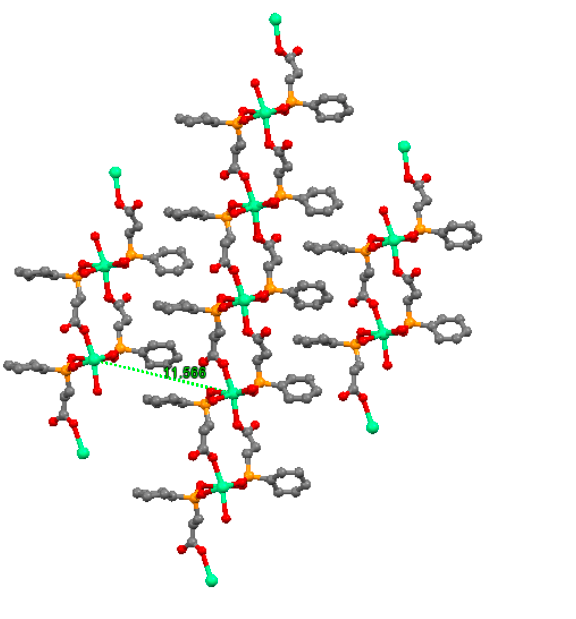
Table 3. Comparison of the maximum adsorption capacities given/demonstrated by similar adsorbents in the treatment process of aqueous solutions containing Cd 2+ ions.